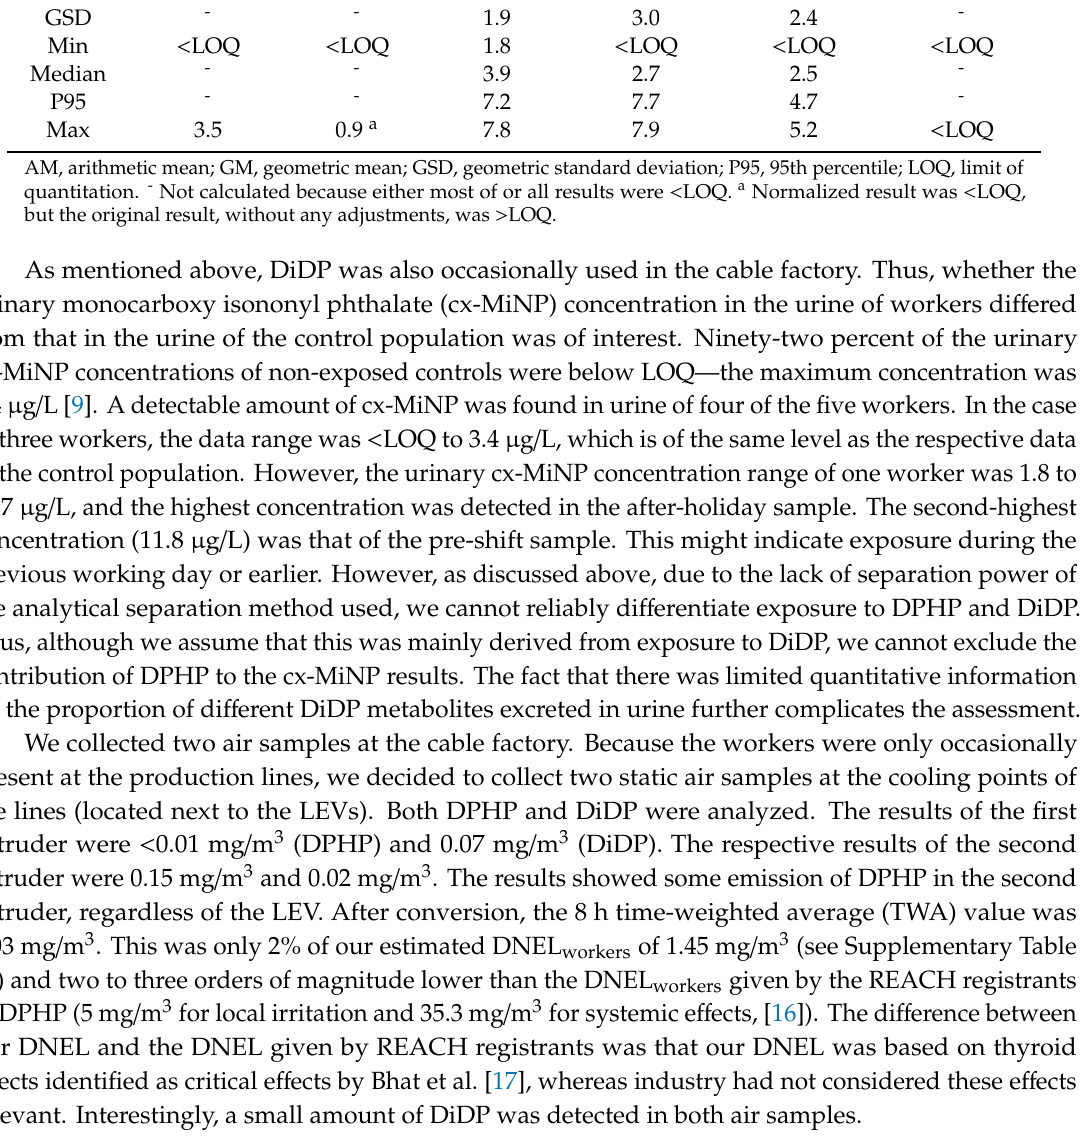
Table 1. Total urinary monohydroxy propylheptyl phthalate (OH-MPHP) concentrations of workers in cable factory ( n = 5) by sampling time. First-morning-void concentrations of occupationally non-exposed control population ( n = 60) are provided for comparison [9]. Concentrations ( µ g / L) were normalized to a specific gravity of 1.021. Workers (Cable Factory) Non-Exposed Post-Shift Next After Pre-Shift Post-Shift Evening Morning Holiday AM - - 4.1 4.0 2.6 - GM - - 3.5 2.7 2.1 - - 1.9 3.0 2.4 - < LOQ < LOQ 1.8 < LOQ < LOQ < LOQ Median - - 3.9 2.7 2.5 - 5.2 <